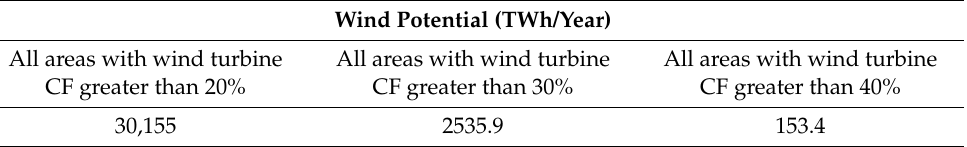
Table 20. Areas associated with different wind turbine CF. Wind Potential